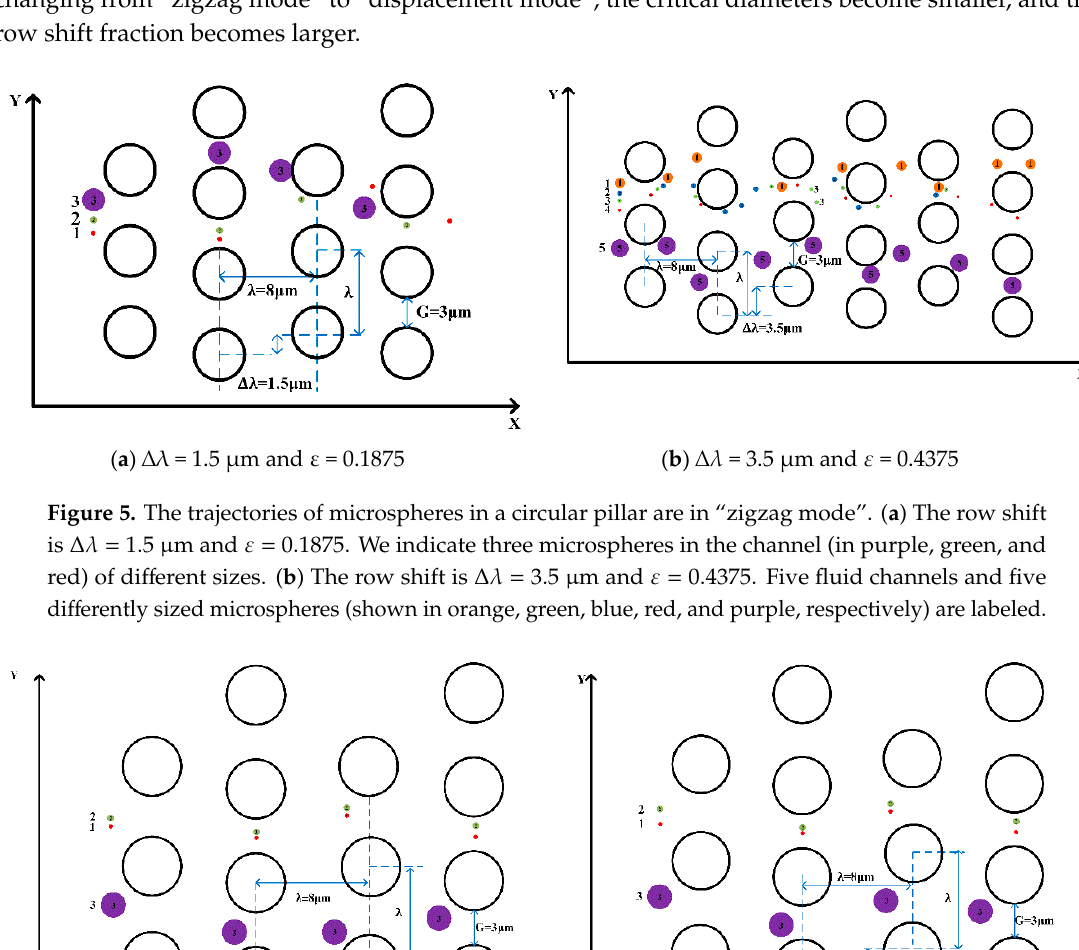
Figure 5. The trajectories of microspheres in a circular pillar are in “zigzag mode”. ( a ) The row shift is ∆ λ = 1.5 µm and ε = 0.1875. We indicate three microspheres in the channel (in purple, green, and red) of different sizes. ( b ) The row shift is ∆ λ = 3.5 µm and ε = 0.4375. Five fluid channels and five differently sized microspheres (shown in orange, green, blue, red, and purple, respectively) are labeled.